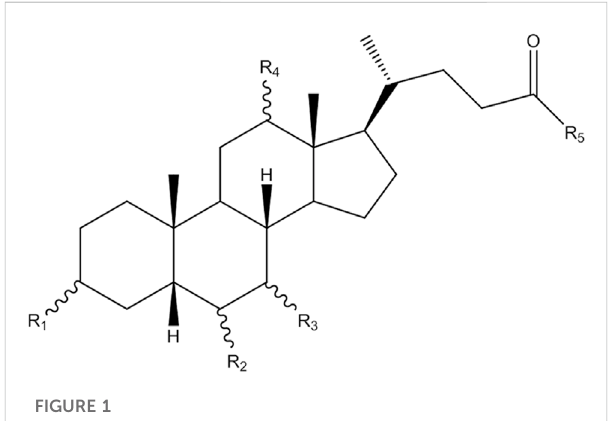
FIGURE 1 The structure of bile acids.